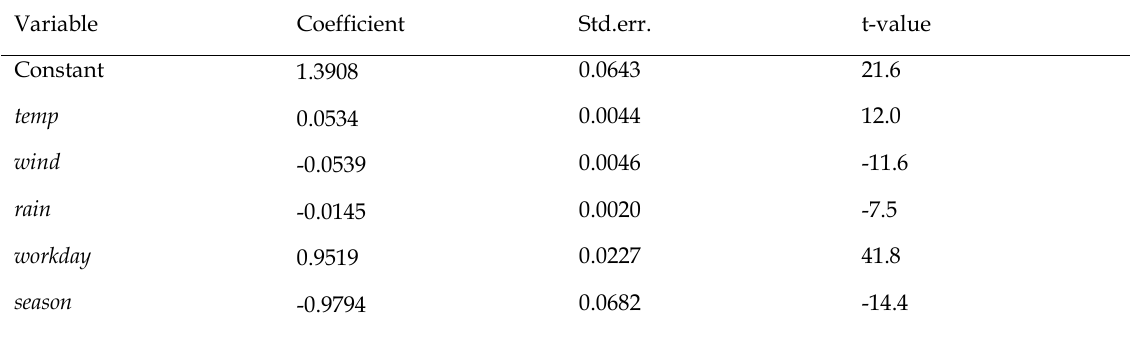
Table 2. Estimation results using the Prais-Winsten correction for serial correlation